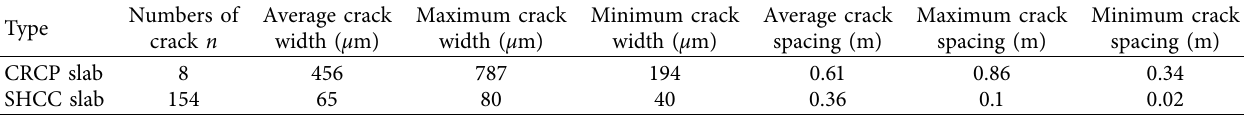
Figure 12: Comparison of crack distribution between CRCP slab and SHCC slab (unit: cm). (a) Crack distribution of CRCP slab [18]. (b) Crack distribution of SHCC slab. Table 7: Comparison of measured crack width and spacing between CRCP slab [18] and SHCC slab.